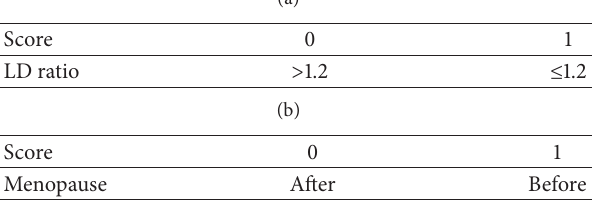
Table 2: (a) LD score. (b) Menopause score.